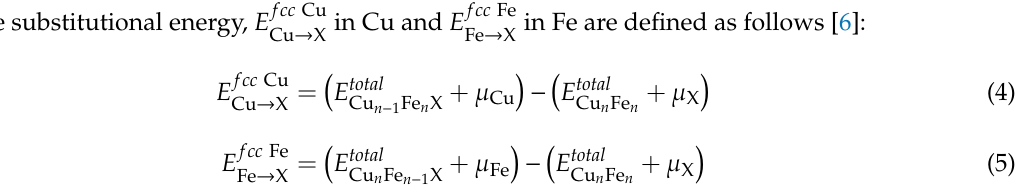
Figure 1. Structure of Cu(100) / γ –Fe(100) interface. The di ff erent layers of the interface area are marked with 1–8.